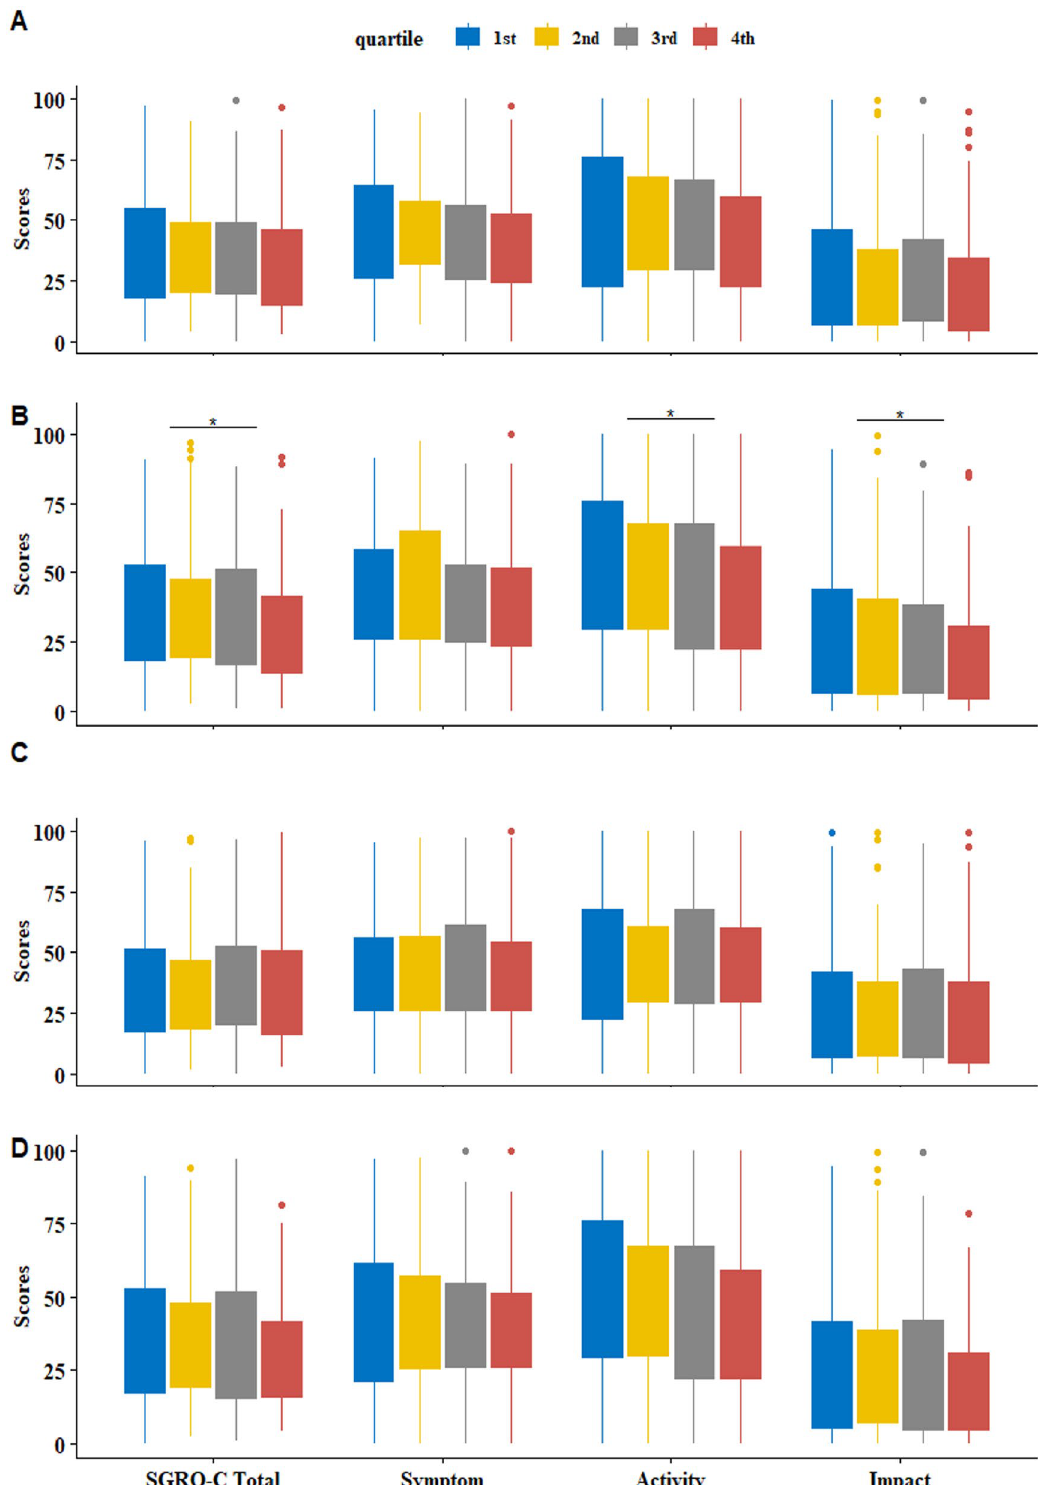
Figure 2. SGRQ-C in year after by ΔFVC quartile and ΔFEV 1 quartile. For comparison, post-hoc analyses by Bonferroni method were performed between the groups, such as ΔFVC quartile and ΔFEV 1 quartile. Baseline SGRQ-C by ΔFVC quartile ( A ) and ΔFEV 1 quartile ( C ) did not show statistical difference between four groups in post-hoc analyses. Comparison of SGRQ-C (1 year) by ΔFVC quartile ( B ) showed a significant difference between the groups in post-hoc analyses. Especially, SGRQ-C activity and impact scores were different between the four groups and showed negative relationship according to the increase of ΔFVC quartile. On the other hand, SGRQ-C (1 year) by Δ FEV 1 quartile ( D ) did not show the statistical difference between the groups. * p value < 0.05. Δ annual changes of the postbronchodilator values,